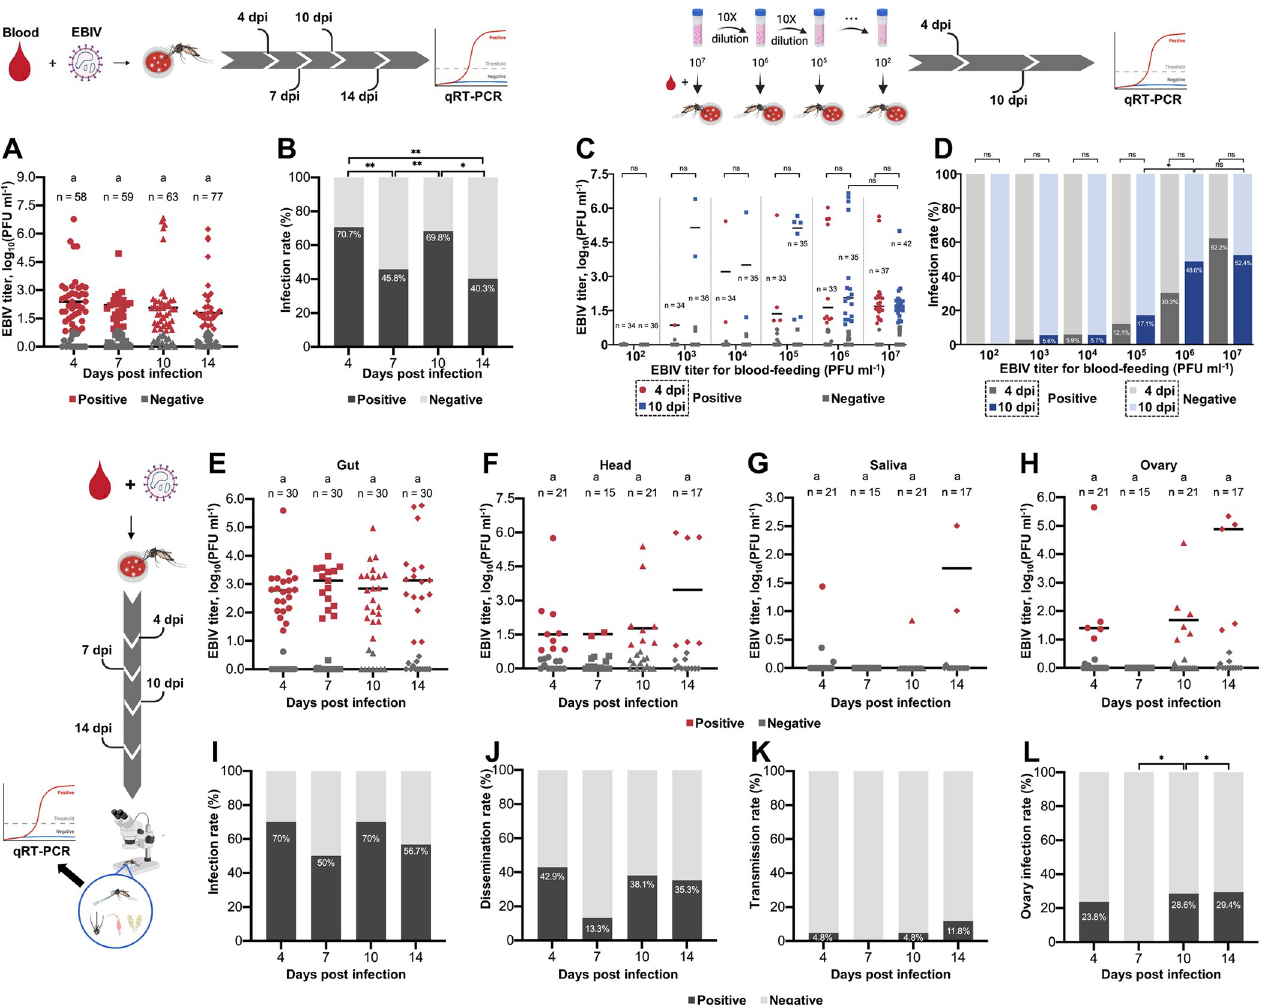
Fig 1. EBIV infection rates of Ae . aegypti through oral feeding. EBIV titers (A) and infection rates (B) of mosquitoes at 4, 7, 10 and 14 days after feeding on blood meal containing 3.7 × 10 6 PFU ml − 1 EBIV. EBIV titers (C) and infection rates (D) of mosquitoes from six serial viral titer groups at 4 and 10 days after feeding on blood meal containing 10 2 to 10 7 PFU ml − 1 EBIV. EBIV titers in gut (E), head (F), saliva (G) and ovary (H) samples of mosquitoes at 4, 7, 10 and 14 days after feeding on blood meal containing 6.4 × 10 6 PFU ml − 1 EBIV. Infection rates (I), dissemination rates (J), transmission rates (K) and ovary infection rates (L) of mosquitoes at 4, 7, 10 and 14 days after feeding on blood meal containing 6.4 × 10 6 PFU ml − 1 EBIV. Each dot represents an individual mosquito. The same letters indicate no significant differences (multiple comparisons using non-parametric Kruskal-Wallis analysis). Differences in the rates were analyzed with Fisher’s exact test ( � : p � 0.05, �� : p � 0.01, ��� : p � 0.005 and ���� : p � 0.001).